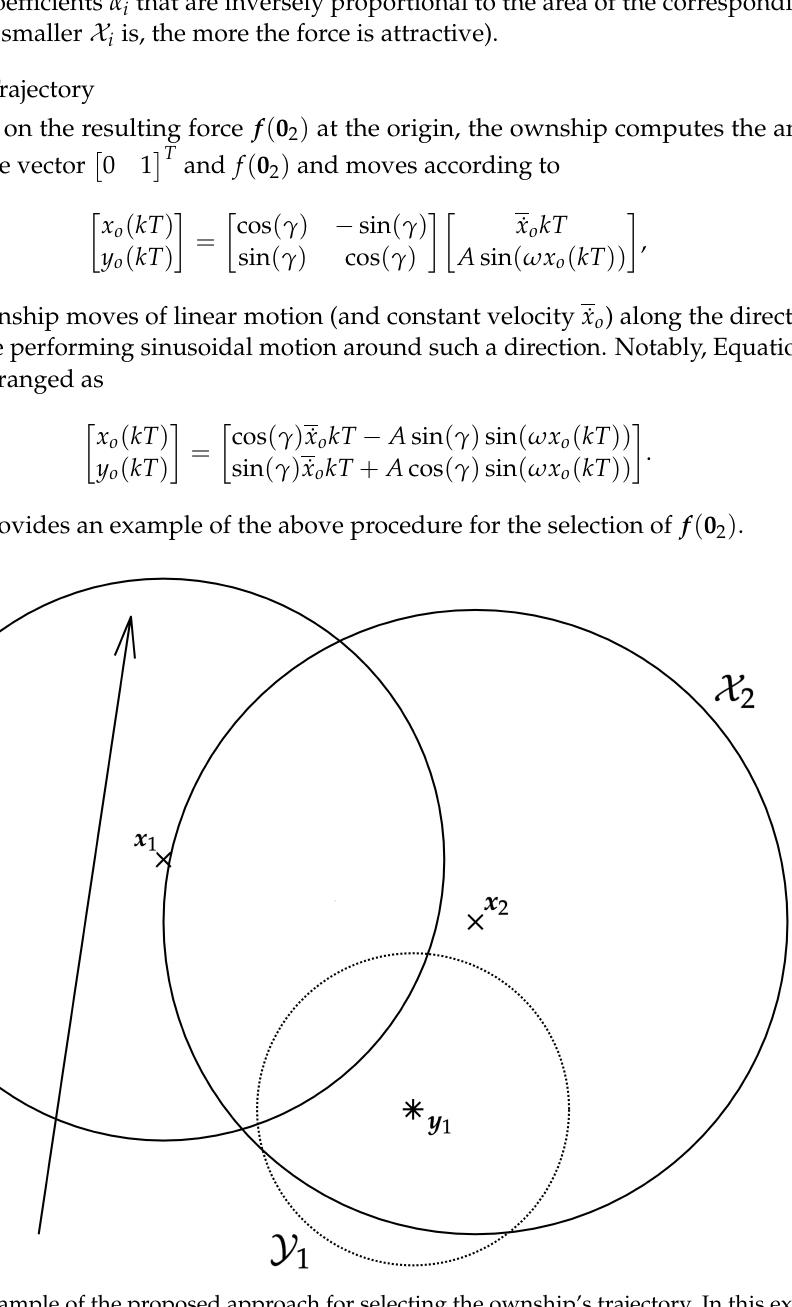
Figure 1. Example of the proposed approach for selecting the ownship’s trajectory. In this example, we consider two sets, X 1 and X 2 , and one setm Y 1 , represented by the circles shown with a solid line and by a dotted line, respectively. The points x 1 and x 2 and the point y 1 (i.e., the centers of the circles) are shown with an x mark and with a cross, respectively. In this example, we choose α 1 and α 2 equal to the area of X 1 and X 2 , respectively, while β 1 is the reciprocal of the area of Y 1 . The resulting direction for the ownship is shown with an arrow (the initial position for the ownship is given by the starting endpoint of the